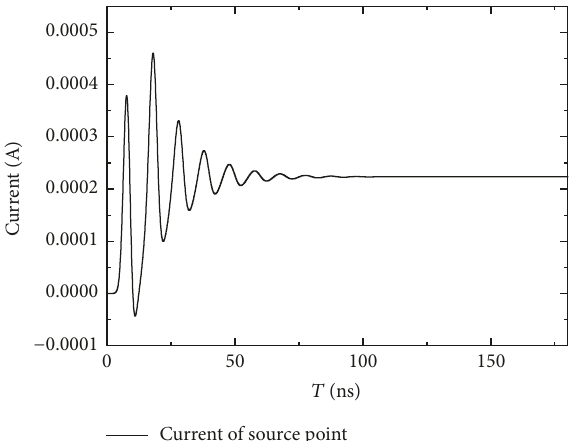
Figure 10: Current of source point.